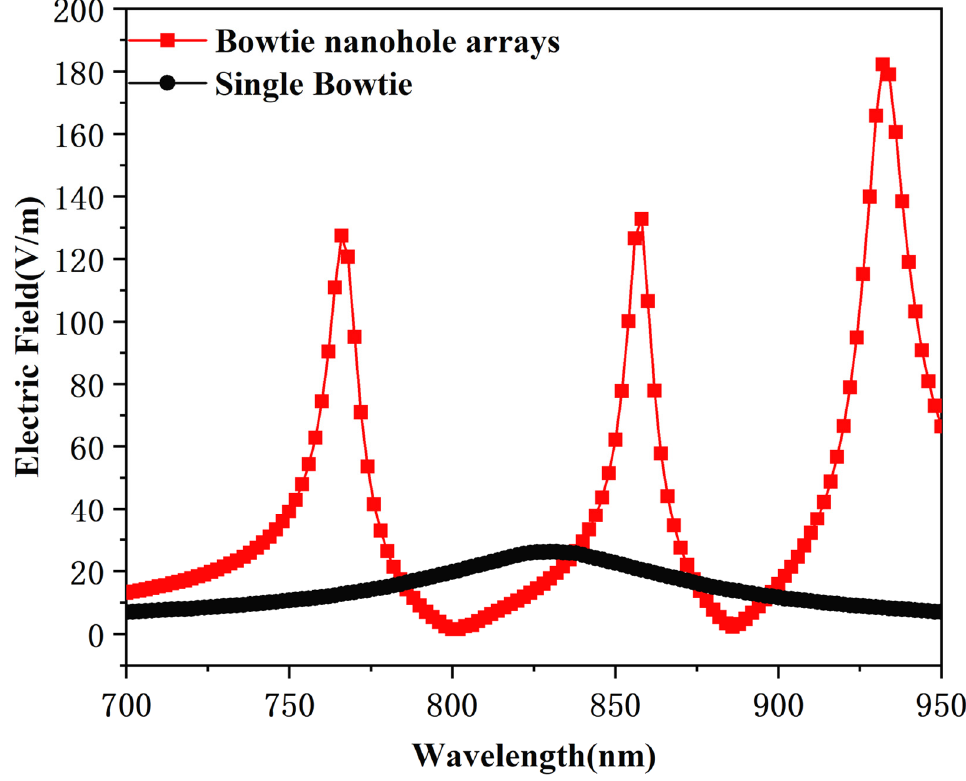
Figure 3. Simulated electric field at the center of the bowtie nanohole arrays (red square line) and the single bowtie (black circle line).